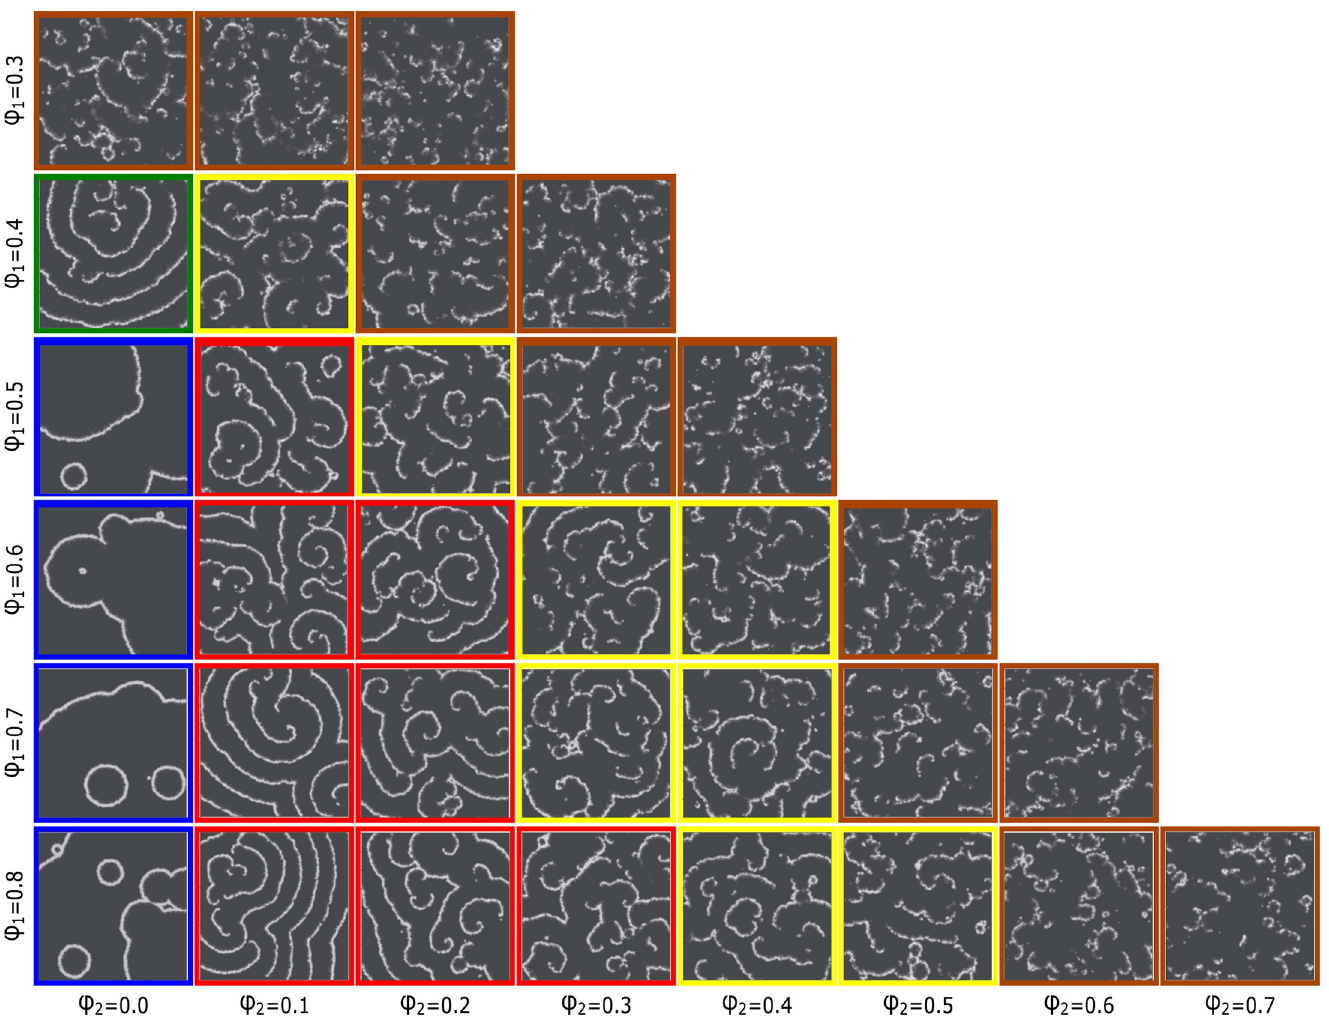
Fig 4. (Color online) disposition of pattern snapshots on a common instance of time in lattices of 400 × 400 size, covered with mixed populations with different pairs of ϕ 1 and ϕ 2 . ϕ 1 is the population density of the whole cells on each lattice and ϕ 2 is the fraction of reactive/less-cooperative cells among the population. The related row and column of each pattern in the array are appointed by their ϕ 1 and ϕ 2 indicated in vertical and horizontal margins, respectively. For example, the bottom row includes the systems with the same population density of individuals ϕ 1 = 0.8 but with a variant fraction of reactive/less-cooperative ones ϕ 2 . Similar patterns are enclosed with a colored border. Pure systems are arranged in the first column.